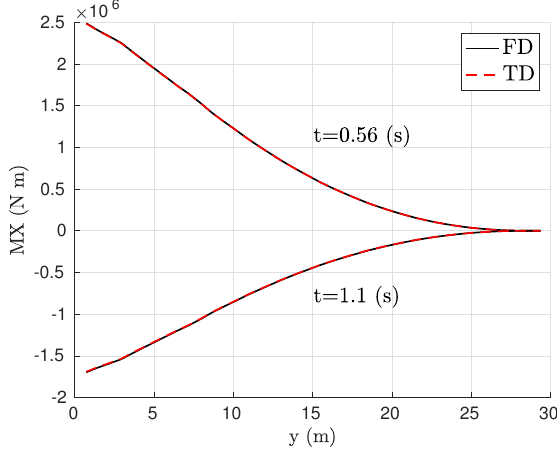
Figure 12. Incremental bending moment MX over the right wing component at different time instants for M ∞ = 0.85, h = 7640 (m), H = 106.68 (m) and α eq = 1 (deg). Two rigid-body modes and one flexible mode considered. Results obtained by the FSM with the generalized state-space model in the time domain (TD) of 81 states compared to the reference model in the frequency domain